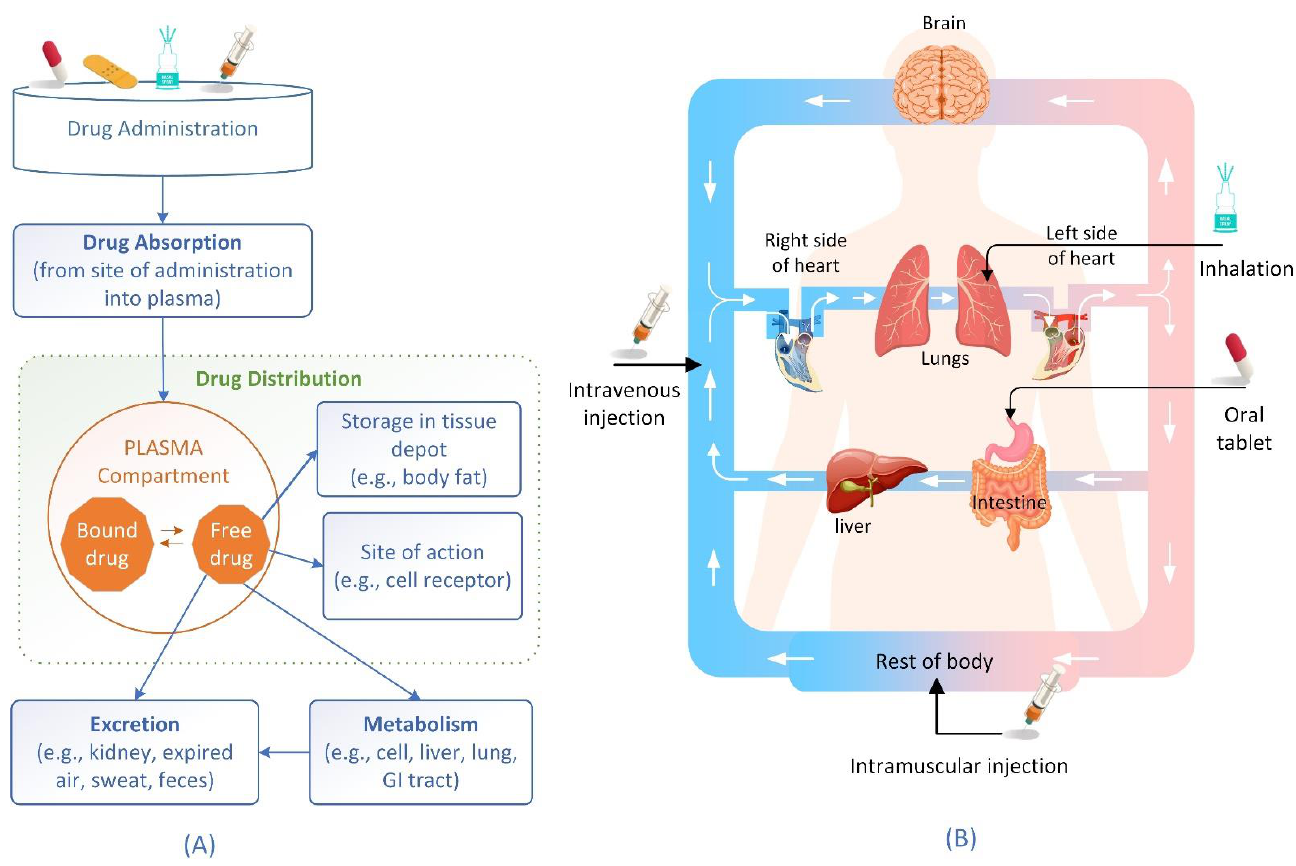
Figure 1. ( A ) Schematic description of the pharmacokinetic (ADME) process. ( B ) Drug administration and drug distribution process in the body.